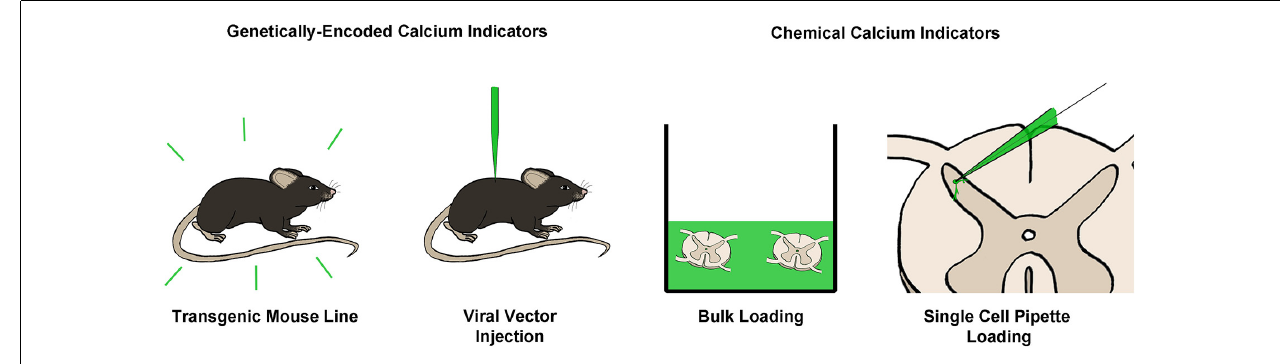
FIGURE 4 | Common techniques for loading of calcium indicators. Calcium indicators can broadly be categorized into genetically-encoded (GECIs) or chemical calcium indicators. GECIs can be introduced via transgenic mouse lines or through the injection of a viral vector containing a GECI into the target tissue. Chemical calcium indicators can be introduced in several ways, however, the most common is through bulk loading with an AM-ester bound indicator, or via single-cell pipette loading. Both of these techniques can be performed in vitro or in vivo